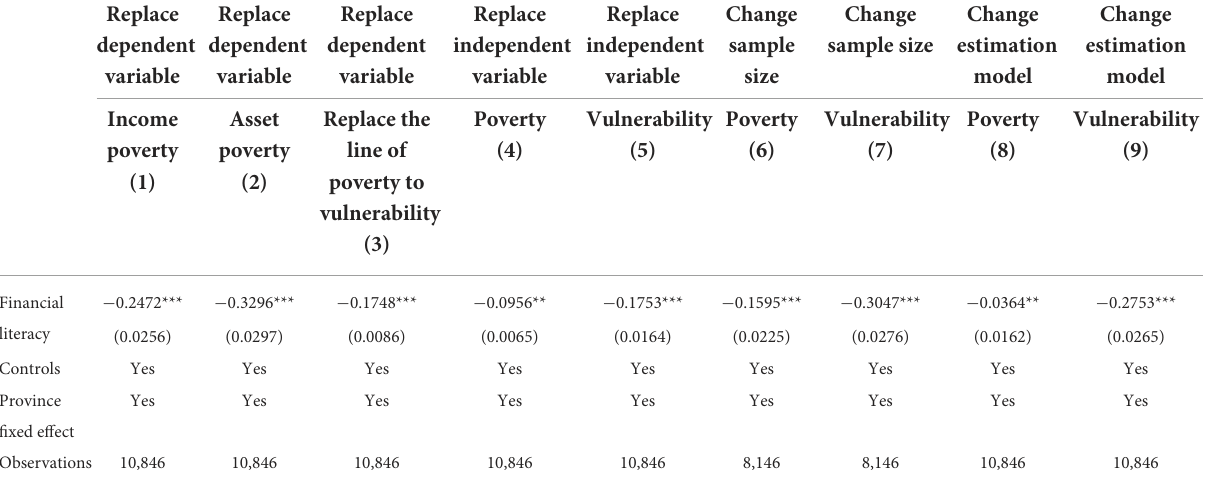
TABLE 7 Robustness tests: substitution variables, sample size, and estimation